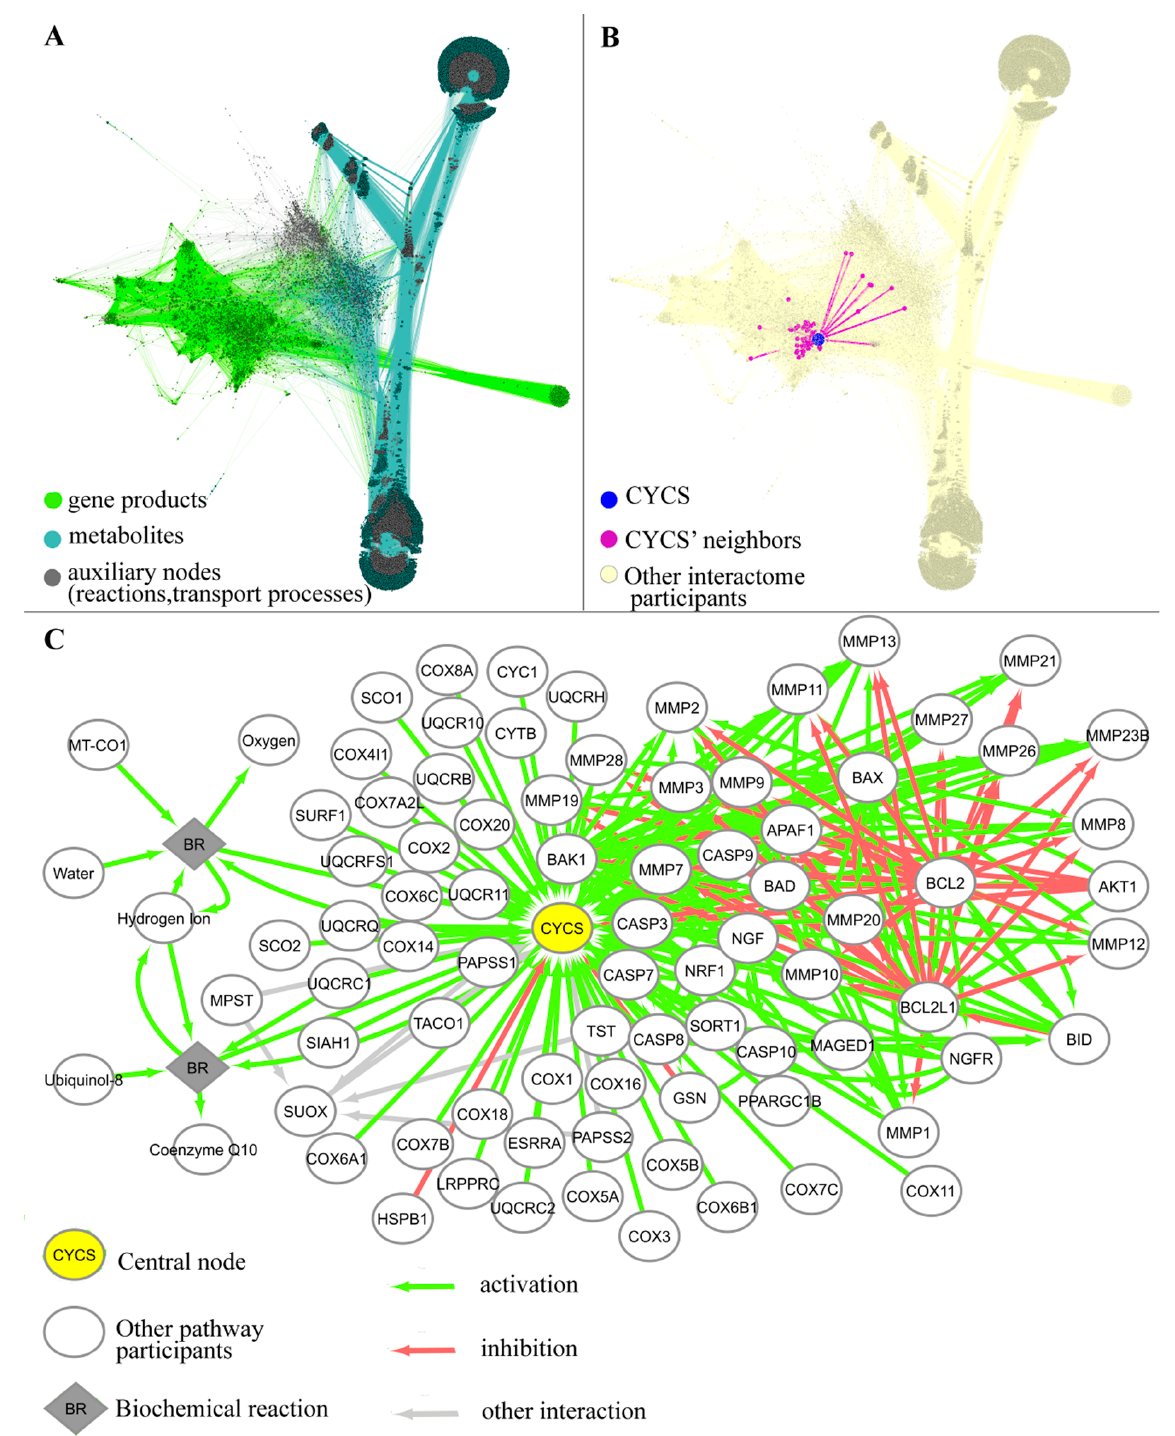
Figure 1. ( A ) Integrated human interactome model (adapted from [27]) combining gene products and metabolites. Edges inherit color of the corresponding nodes. ( B ) Example of gene-centric pathway for gene CYCS , which serves as the central node (enlarged blue dot), and its direct interactors are the pathway participants (violet dots). Edges between the central node and its interactors are shown in violet. ( C ) Detailed scheme of CYCS gene-centric pathway, where CYCS is the central node, and its direct interactors are the pathway participants. Colors of edges denote types of interaction (inhibition, activation,